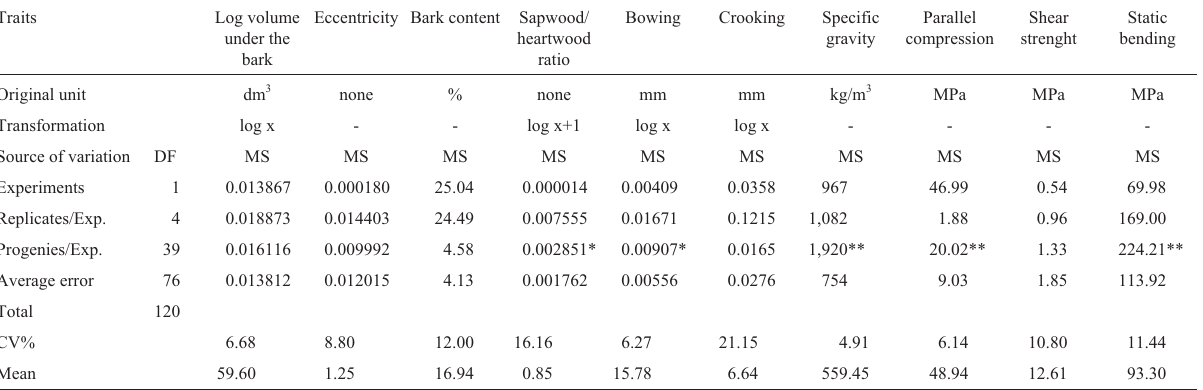
Table 2 - Analysis of variance for several traits in eight-year-old E. grandis on a plot mean basis (two plants). Traits Log volume